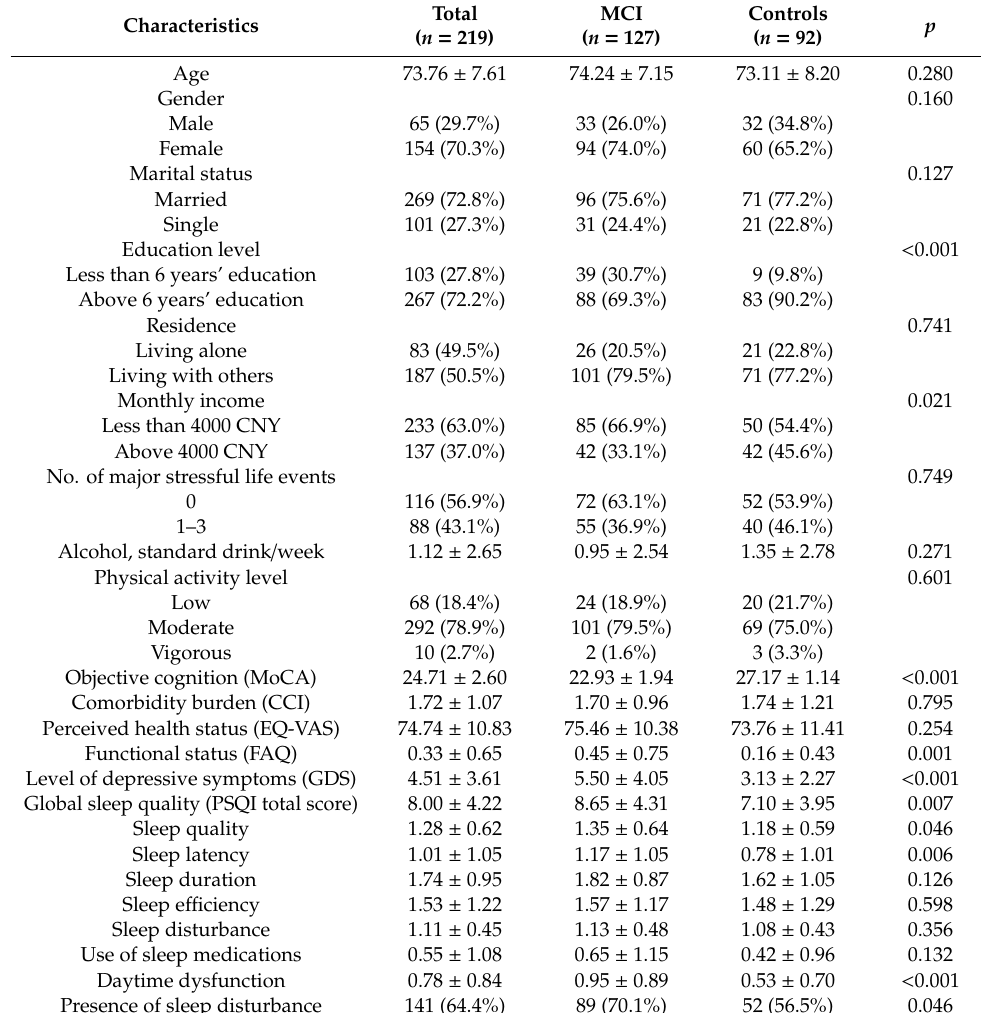
Table 1. Sample characteristics ( n =